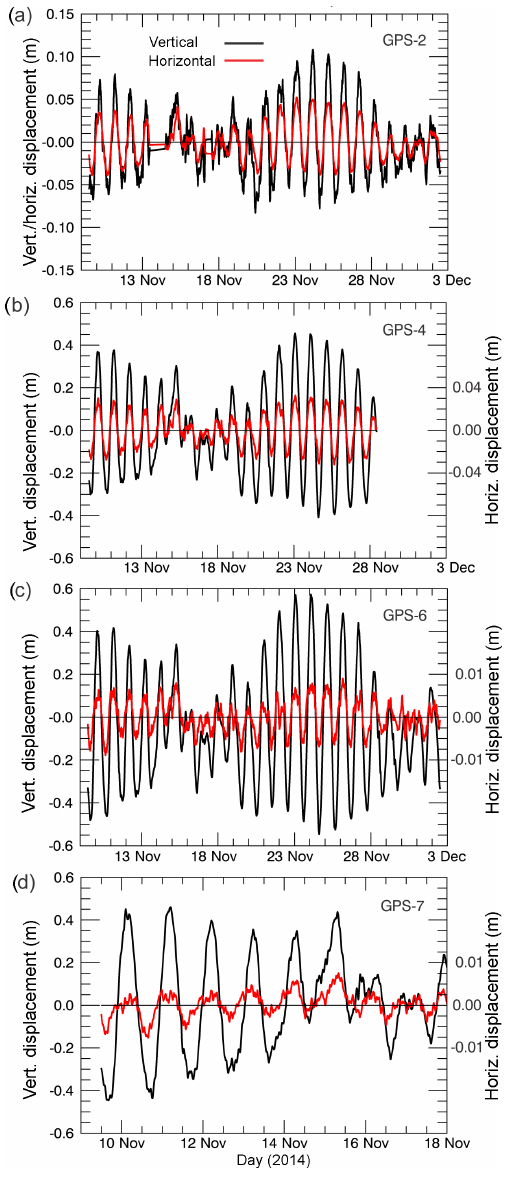
Figure 2. Vertical (black) and horizontal (red) displacements at four GPS stations between 9 November and 2 December 2014. The hor- izontal displacement is the component perpendicular to the ground- ing line with positive values for movements towards White Island (about north).